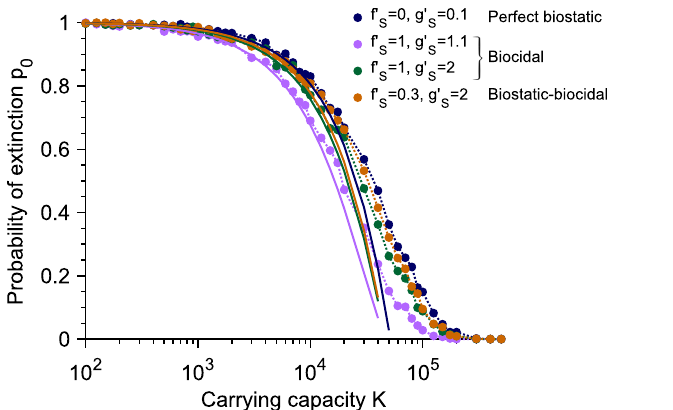
Fig 4. Dependence of the extinction probability p 0 on population size and antimicrobial mode of action. The extinction probability p 0 is plotted versus carrying capacity K for the perfect biostatic drug (corresponding to Fig 1), two different concentrations of biocidal drugs yielding two different death rates g 0 (corresponding to Fig 2) and a drug S with both biostatic and biocidal effects. Markers correspond to simulation results, computed over 10 3 realizations. Solid lines correspond to our analytical predictions from Eqs 1 and 4, respectively, which hold for K � 1/ μ 1 . Parameter values and initial conditions are the same as in Figs 1 and 2, respectively, and the period of alternations is T = 10 3 , which is in the large-period regime.